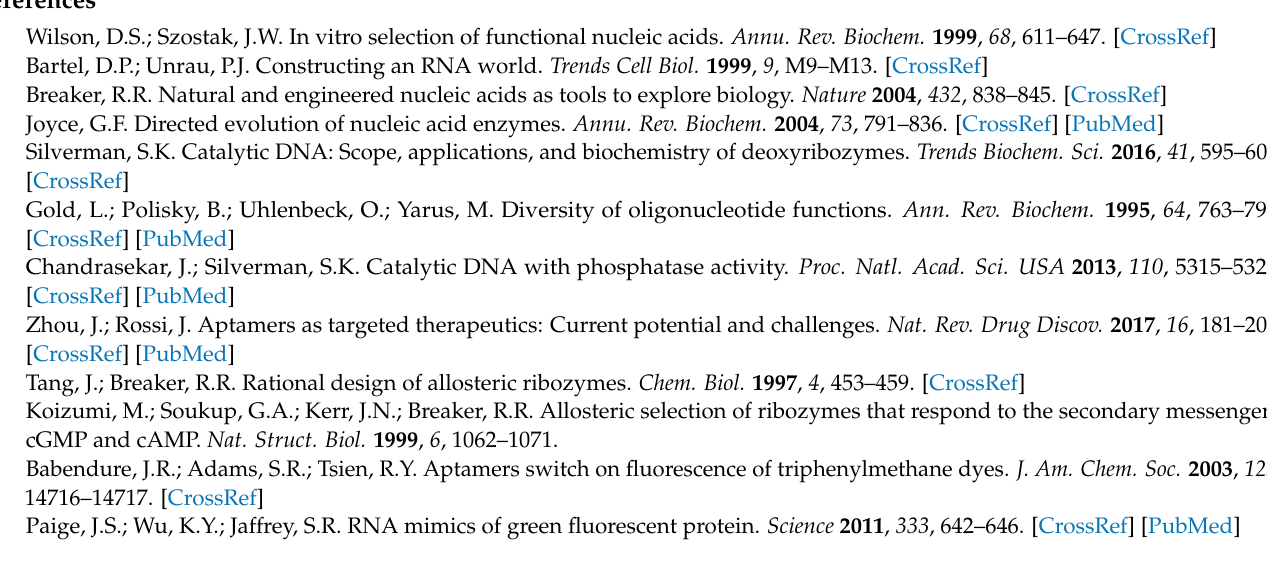
Figure S4: Enrichment of stem variants in secondary structure libraries relative to randomly mutage- nized libraries, Figure S5: Secondary structure libraries based on known motifs for library sizes of 10 12 sequences, Figure S6: Secondary structure libraries based on known motifs for library sizes of 10 9 sequences., Figure S7: Secondary structure libraries based on known motifs for library sizes of 10 6